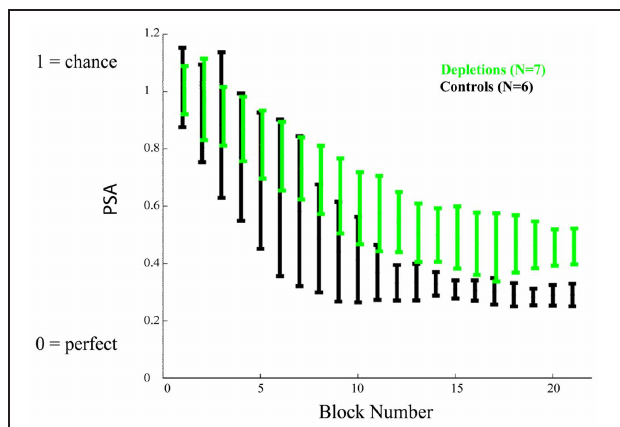
FIGURE 4 | Learning experiment , temporal evolution of the psychometric curves. Comparison of psychometric curves of the control (ACSF vehicle) and the cholinergic depletion (192 IgG-Saporin) groups as they evolve over time (training block number). Each block is a rolling average of 5 sessions. After a few sessions, the animals in both groups begin to inhibit responding to the frequencies that are the most distant from the CS + . Once the psychometric curves become stable, it is evident that the